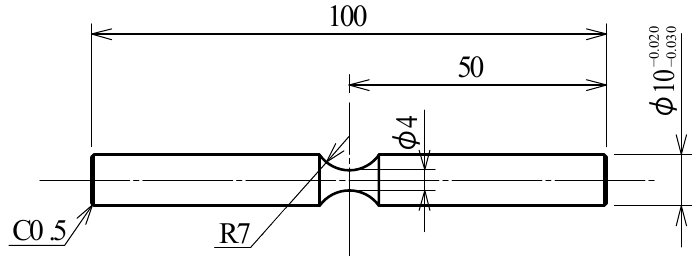
Figure 2. Specimen configuration.